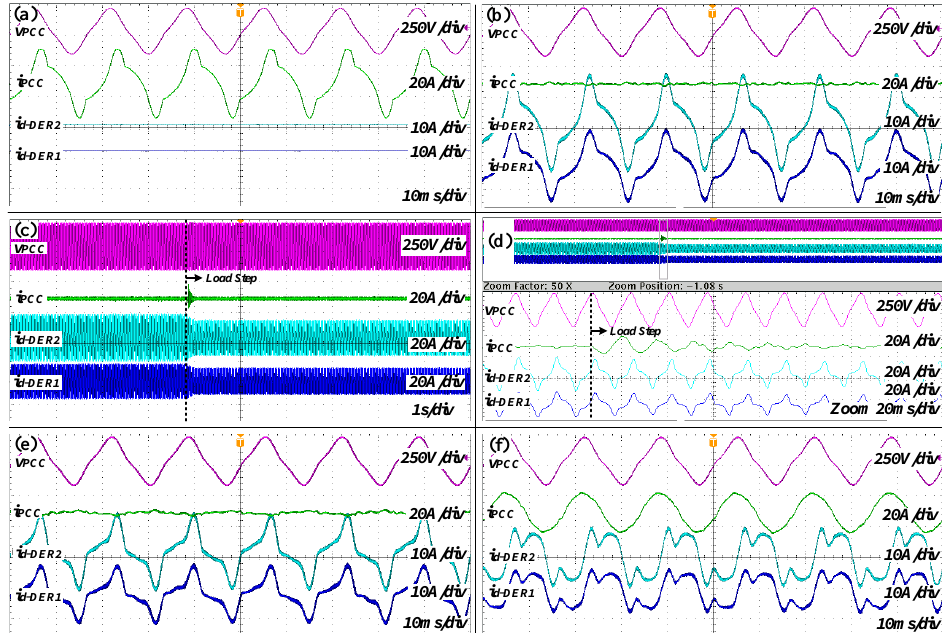
Figure 12. Operation of the GCBC strategy coordinating DERs under distorted voltages. ( a ) Grid voltage and current with DERs disabled; ( b ) active, reactive, and harmonic current-sharing function- ality; ( c ) load step applied to ( b ) by disconnecting load L 2 ; ( d ) zoom-in view of ( c ); ( e ) steady-state condition of ( d ); ( f ) reactive and harmonic current-sharing functionality. From top to bottom: PCC voltage and current, d-DER 2 and d-DER 1